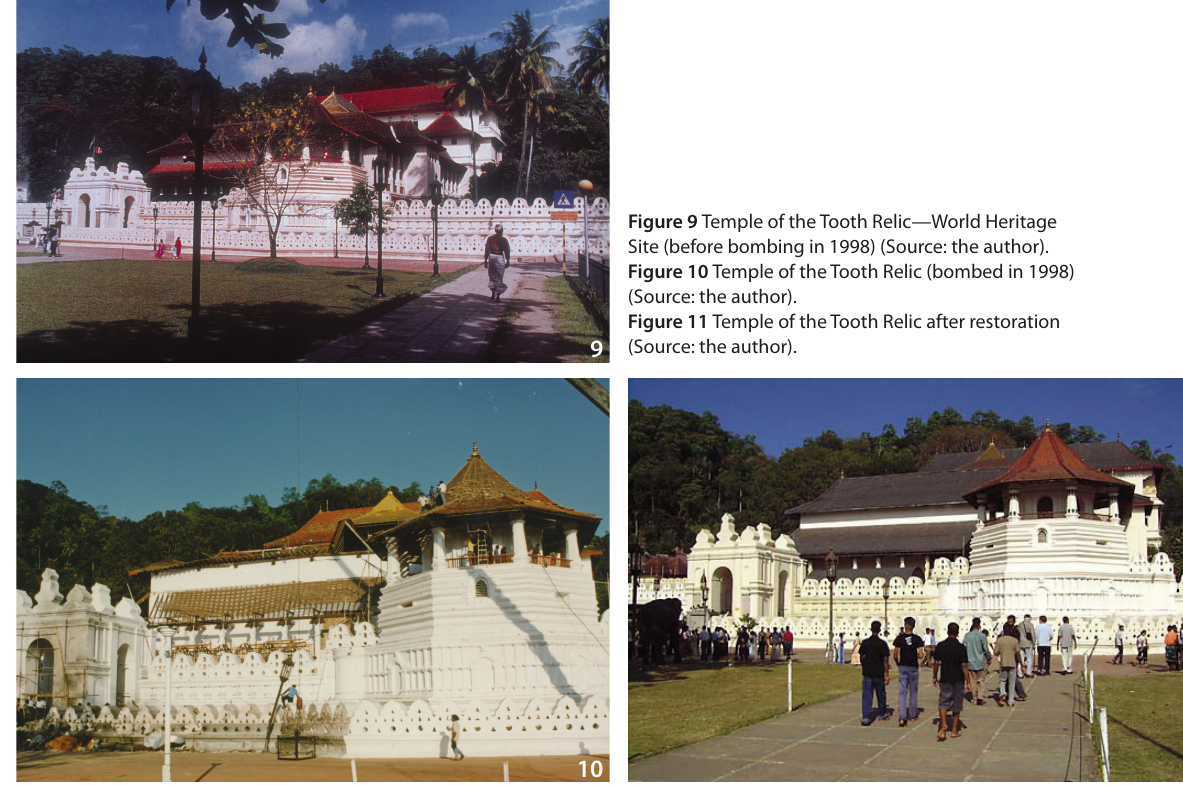
Figure 9 Temple of the Tooth Relic—World Heritage Site (before bombing in 1998) (Source: the author). Figure 10 Temple of the Tooth Relic (bombed in 1998) (Source: the author). Figure 11 Temple of the Tooth Relic after restoration (Source: the author).